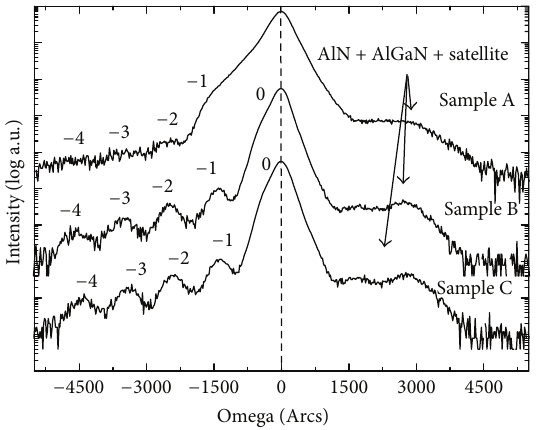
Figure 2: DCXRD Omega-2theta rocking curve on GaN (0002) planforthreesamples.ThecenterpeakisdefinedasGaN(002)peak. InGaN diffraction peak is marked as zero order